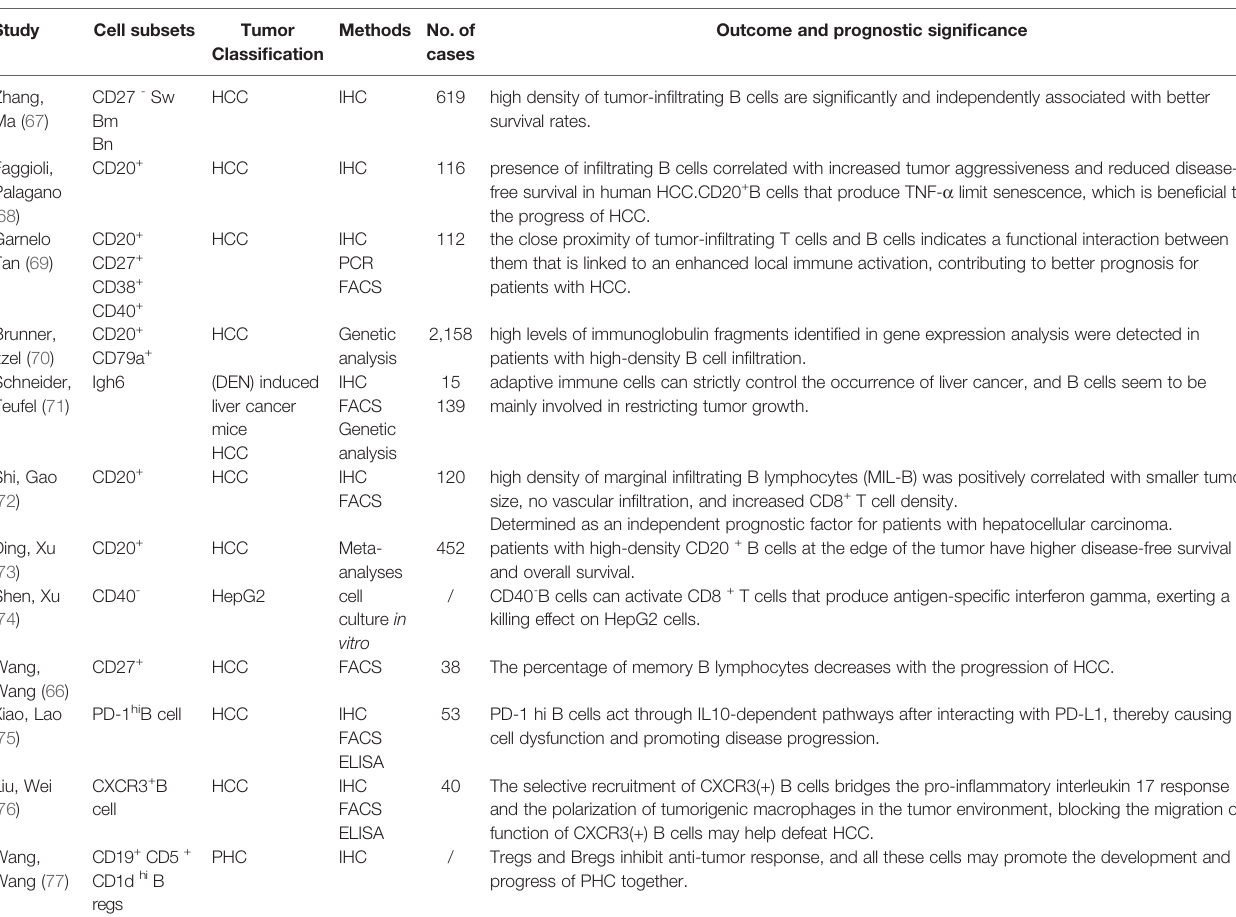
TABLE 1 | Tumor in fl trating B lymphocytes in human hepatocellular carcinoma.